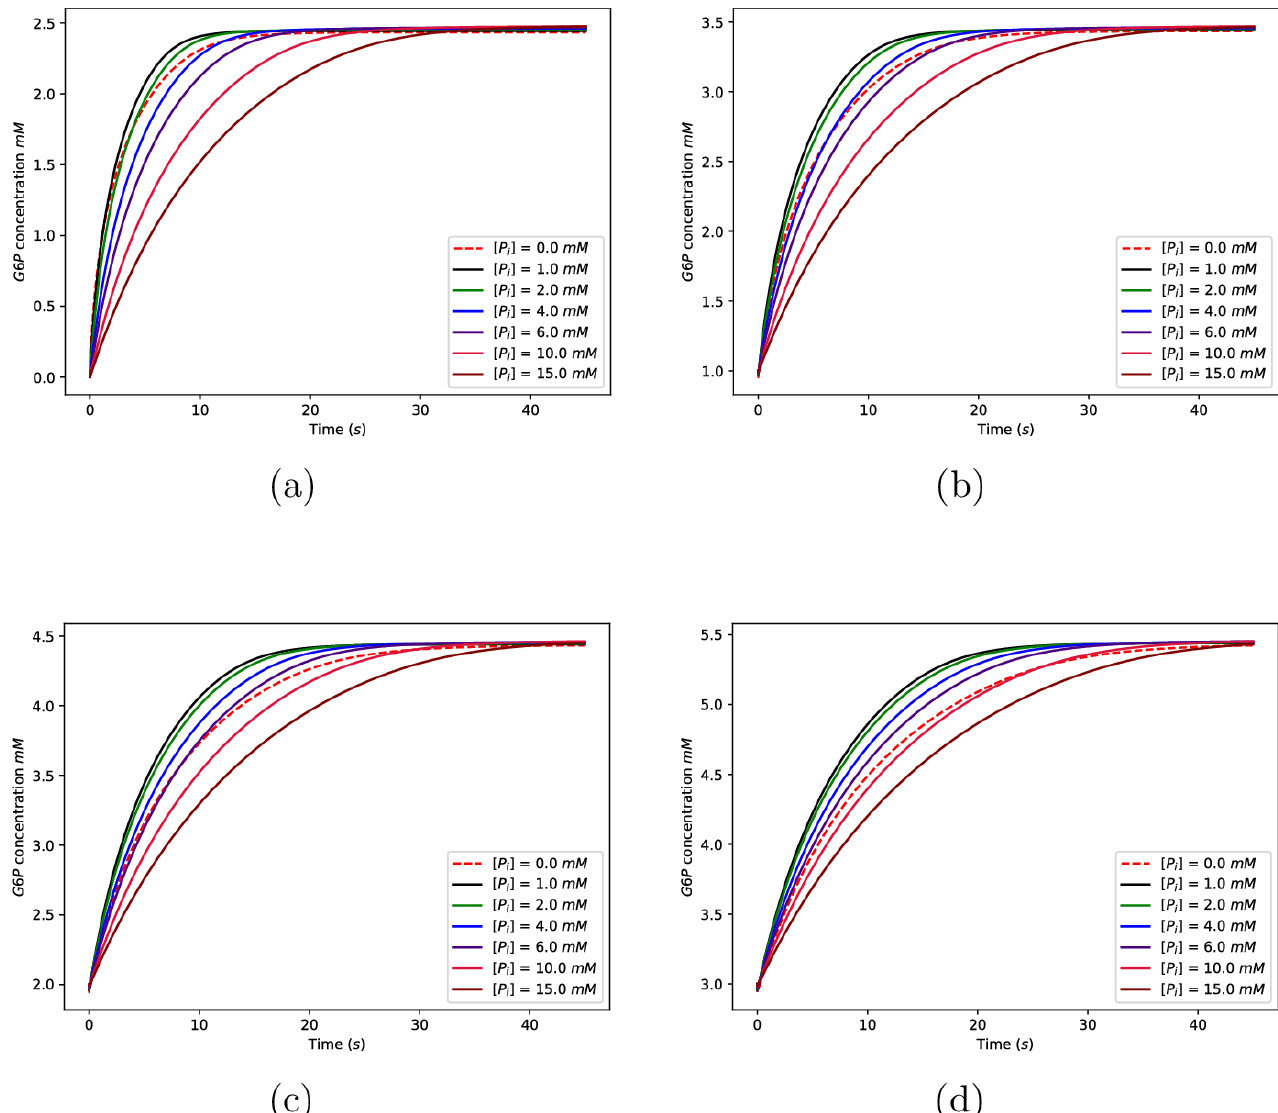
Figure 8. Numerical solutions of the model equations. The graphs show the concentration of G 6 P as a function of time for various initial concentrations of P i and G 6 P . The initial concentrations for P i are given in the legends on the graphs, and the initial G 6 P concentrations are given by ( a ) 0 mM, ( b ) 1.0 mM, ( c ) 2.0 mM, and ( d ) 3.0 mM. The remaining parameter values can be found in the main